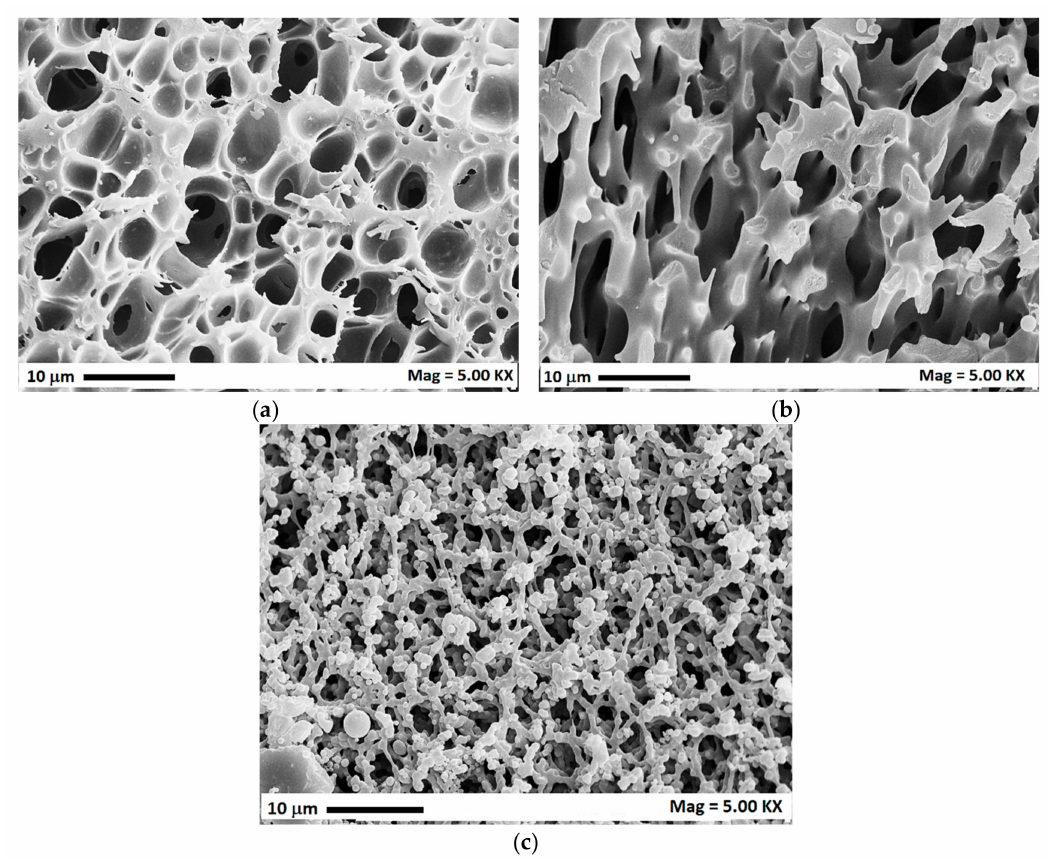
Figure6. Differentmembranemorphologiesobtainedat8MPa,45 ◦ Canddifferentpolymerconcentrations (40, 80 e 240 mg / mL): ( a ) cellular membrane; ( b ) spinodal membrane; ( c ) beads-like